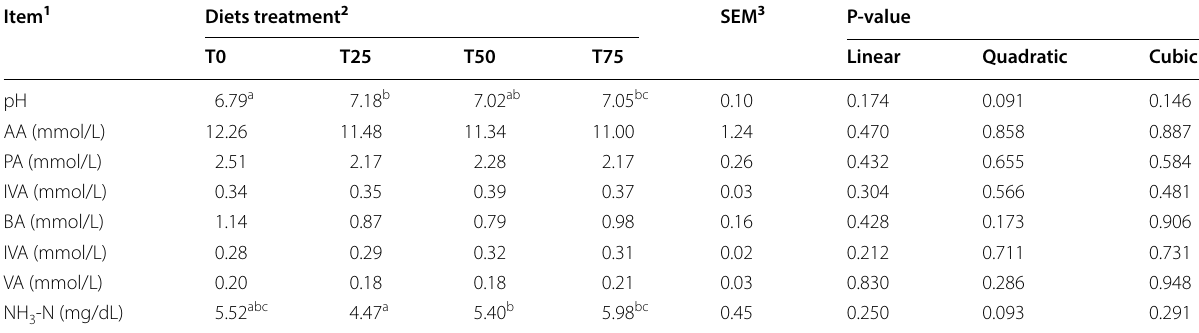
Table 4 Effects of BPS on the hindgut fermentation parameters of Holstein heifers (n